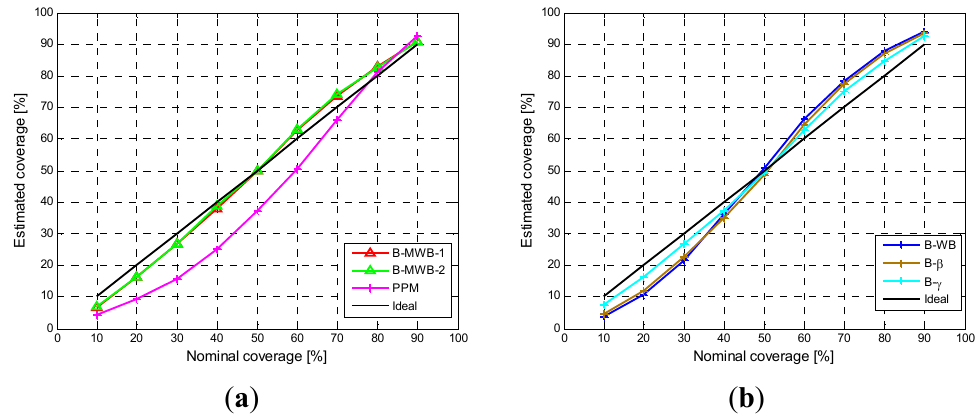
Figure 5. Reliability diagrams for the proposed methods and the reference methods compared to the ideal reliability; ( a ) Proposed methods: B-MWB-1 and B-MWB-2 cases, and PPM; and ( b ) Bayesian methods with unimodal distributions: B-WB, B- β and B- γ